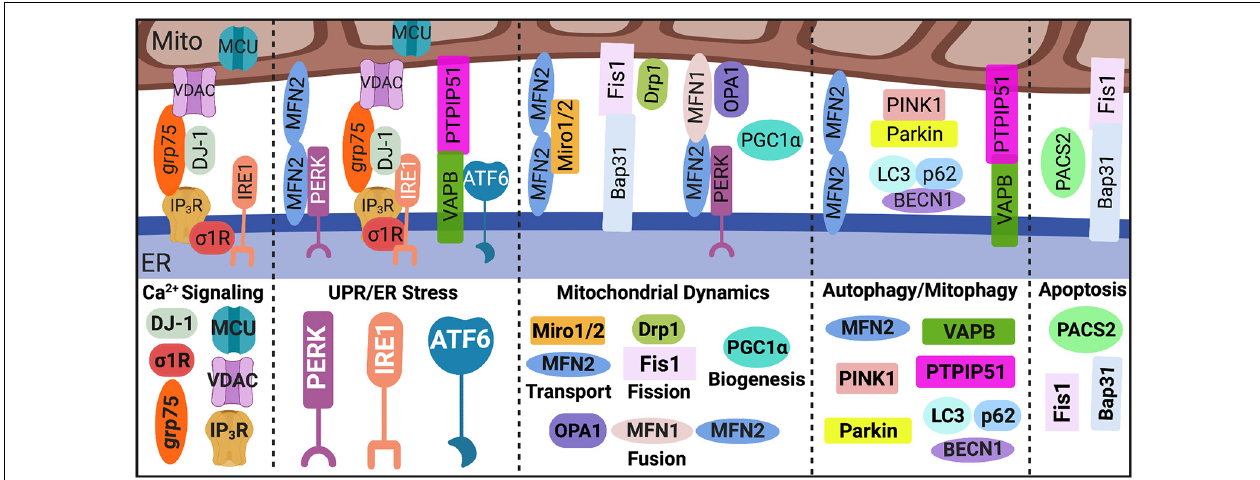
FIGURE 1 | MAM proteome. Direct contact sites between the ER and mitochondria, MAMs, are tightly regulated by key tethering factors: MFN2, VAPB-PTPIP51, IP 3 R-grp75-DJ-1-VDAC, and Bap31-Fis1. Mediators within the ER-mitochondrial interface regulate distinct MAM-mediated mechanisms such as Ca 2 + signaling, UPR/ER stress, mitochondrial dynamics, autophagy/mitophagy, and apoptosis. MAM, mitochondria-associated ER membrane; Mito, mitochondria; ER, endoplasmic reticulum; Ca 2 + , calcium; IP 3 R, inositol 1,4,5-triphosphate receptors; VDAC, voltage-dependent anion-selective channel; grp75, glucose-regulated protein 75 kDa; MCU, mitochondrial Ca 2 + uniporter; σ 1R, sigma-1 receptor; UPR, unfolded protein response; PERK, protein kinase RNA-like endoplasmic reticulum kinase; IRE1 α , inositol-requiring protein 1 α ; ATF6, activating transcription factor 6; MFN, mitofusin; Miro, mitochondrial Rho GTPases; Drp1, dynamin-related protein 1; Fis1, fission 1; OPA1, optic atrophy protein 1; PGC1 α , proliferator-activated receptor γ coactivator 1 α ; PINK1, phosphatase and tensin homolog-induced putative kinase; BECN1, beclin 1; LC3, microtubule-associated protein 1A/1B-light chain 3; VAPB, membrane protein-associated protein B; PTPIP51, protein tyrosine phosphatase-interacting protein 51; PACS2, phosphofurin acidic cluster sorting 2; and Bap31, B cell receptor-associated protein 31. Image created with